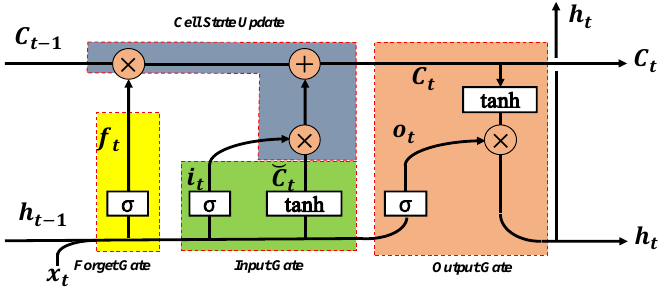
Figure 3. Architecture of a long short-term memory (LSTM) unit.